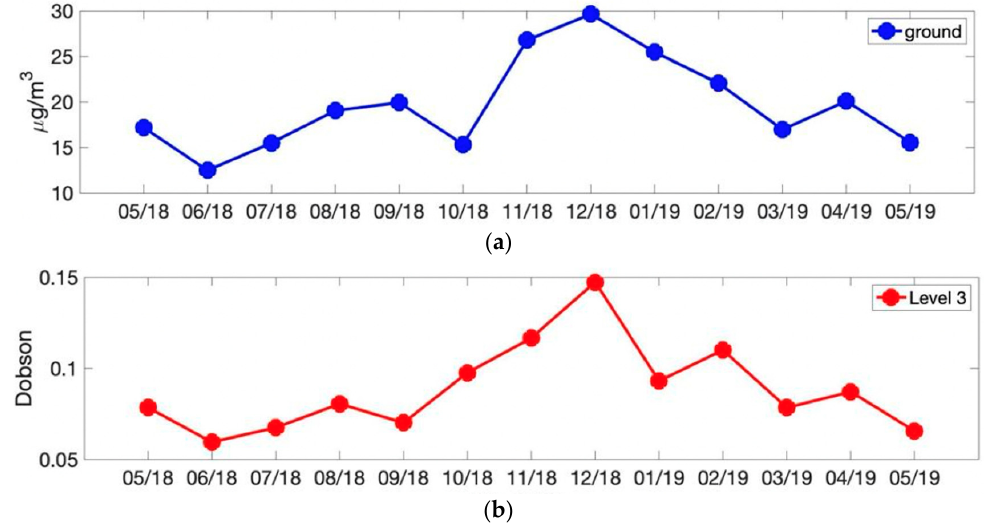
Figure 10. Ground ( a ) and Level 3 ( b ) NO 2 monthly time series for the Avellino station. The analysis refers to the period of May 2018–May 2019.